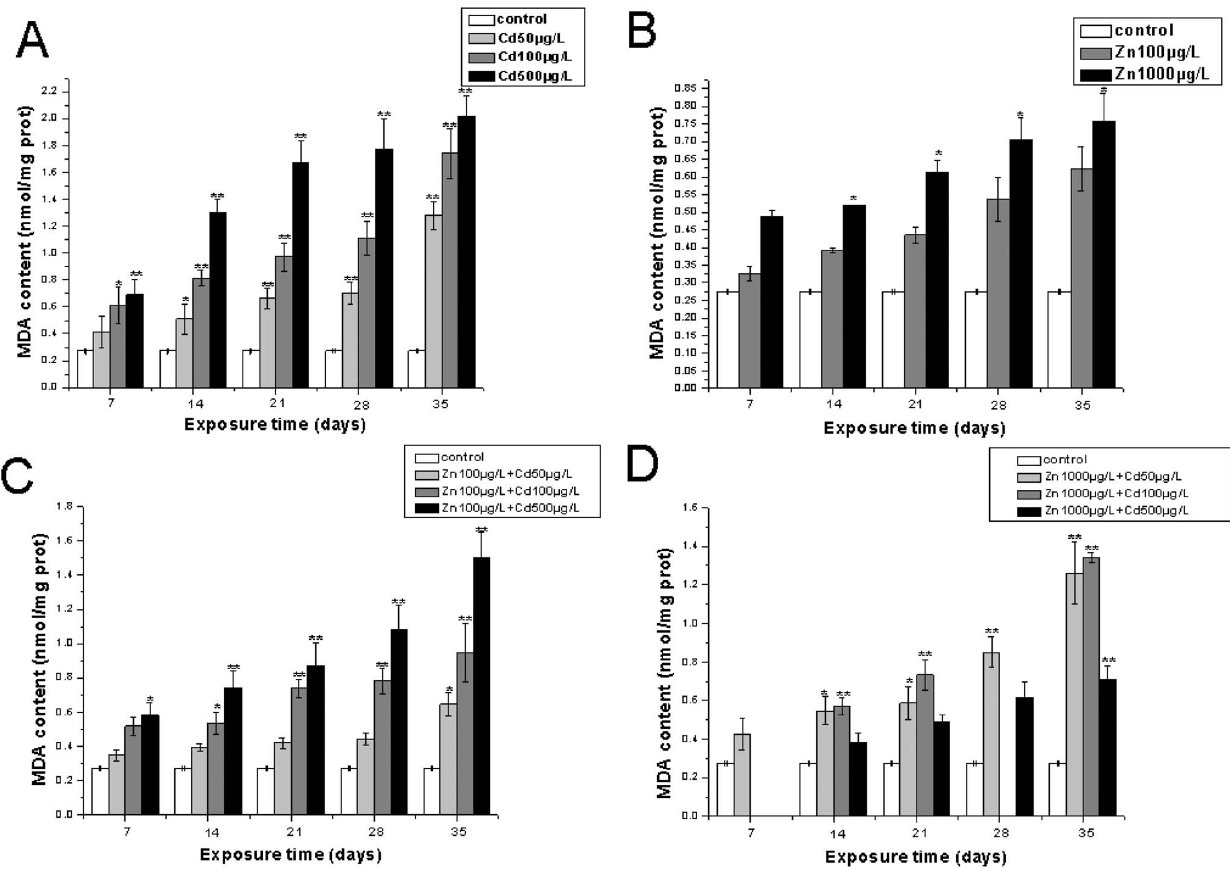
Figure 2. The MDA contents in the hepatopancreas of S.henanense exposed to Cd and Zn either as a single treatment or both metals combined for 7, 14, 21, 28, 35days. Data are expressed as mean values 6 standard error. Statistical significances were analyzed using one-way ANOVA compared to the control, *P , 0.05, **P , 0.01.